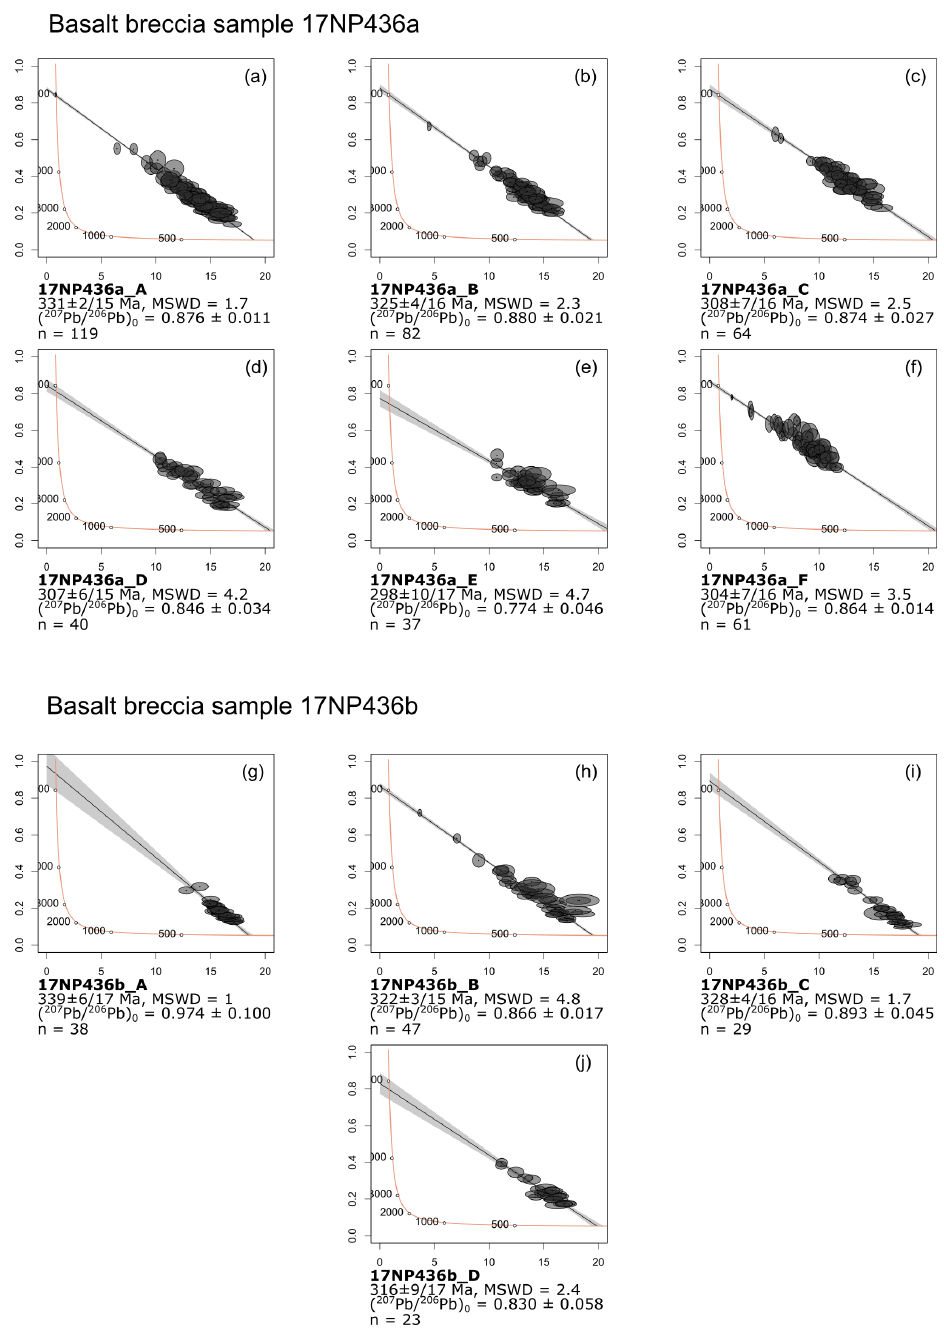
Figure 5. Tera–Wasserburg plots of ablation area ages on basalt breccia samples 17NP436a and 17NP436b. All errors are given as 2 σ